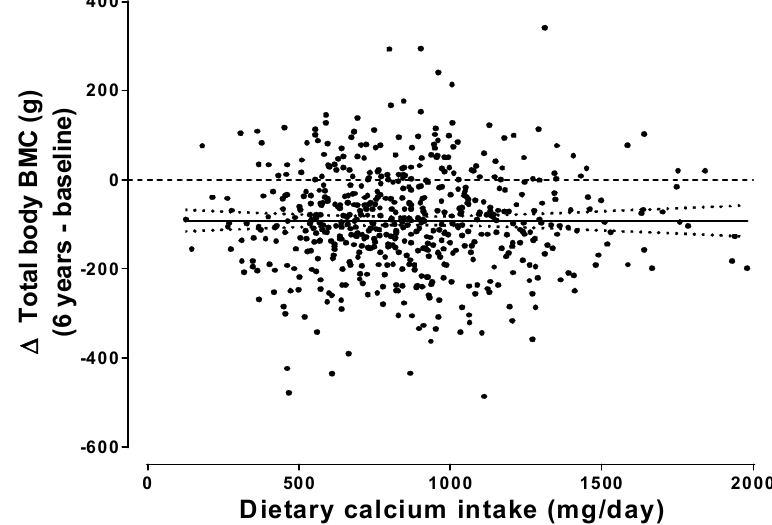
Figure 1. Absolute change ( ∆ ) in total body bone mineral content (BMC) over 6 years in 698 osteopenic postmenopausal women not receiving bone-active medications, in relation to each woman’s average calcium intake assessed at baseline, year 3, and year 6. The regression line (with 95% CIs) for this relationship is shown ( p = 0.99). From Bristow et al., J Clin Endocrinol Metab , 2019 [12]. Used with permission.